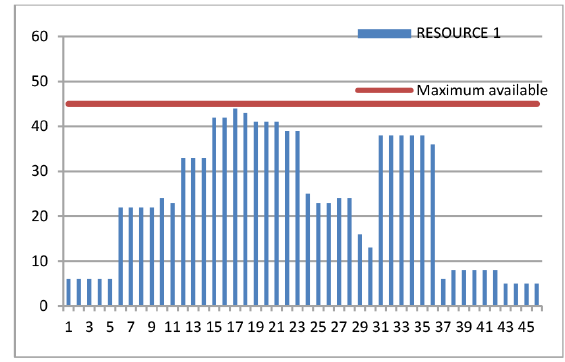
Figure 29. Daily usage of resource 1 throughout the calendar of the project (before using the method)-Experiment 2